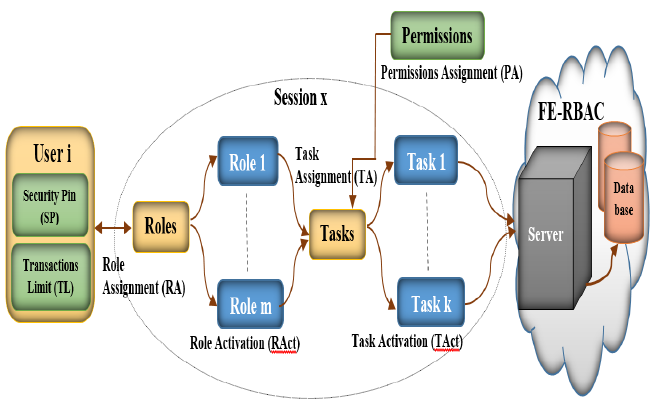
Figure 3. Proposed Efficient and Flexible